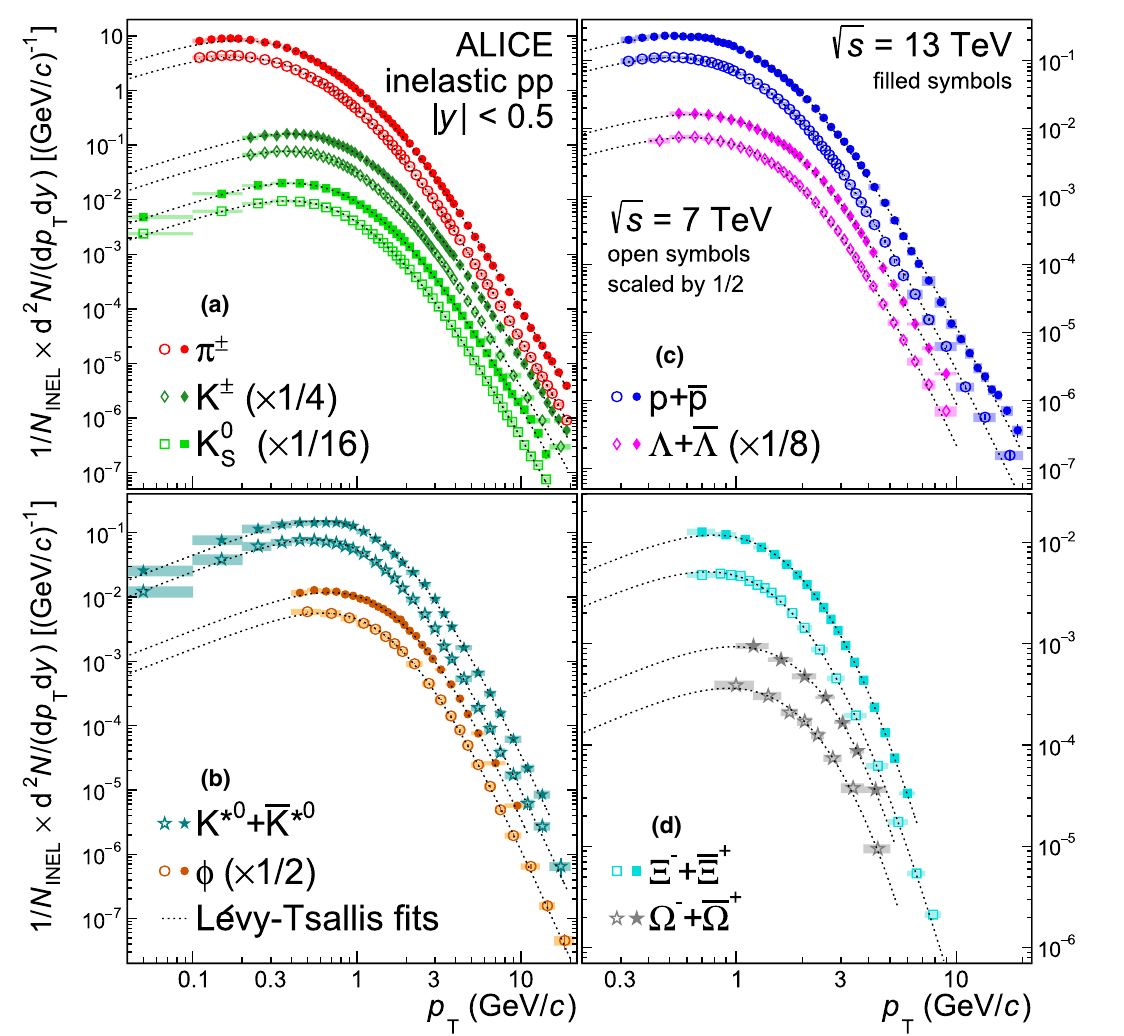
Fig. 5 Transversemomentumspectraoflight-flavorhadronsmeasured as vertical error bars and boxes, respectively. The data points are fitted √ s = 13 TeV at midrapidity ( | y | < 0 . 5) in inelastic pp collisions at using a Lévy–Tsallis function. The normalization uncertainty of + 7 . 3 − √ √ ( ± 2 . 6% ) for pp collisions at s = 7 TeV (open symbols, scaled by a factor (filled symbols) and s = 7 (13) TeV is common to all particle of 1 / 2) [25,27,60]. Statistical and systematic uncertainties are shown species and is excluded from the plotted uncertainties